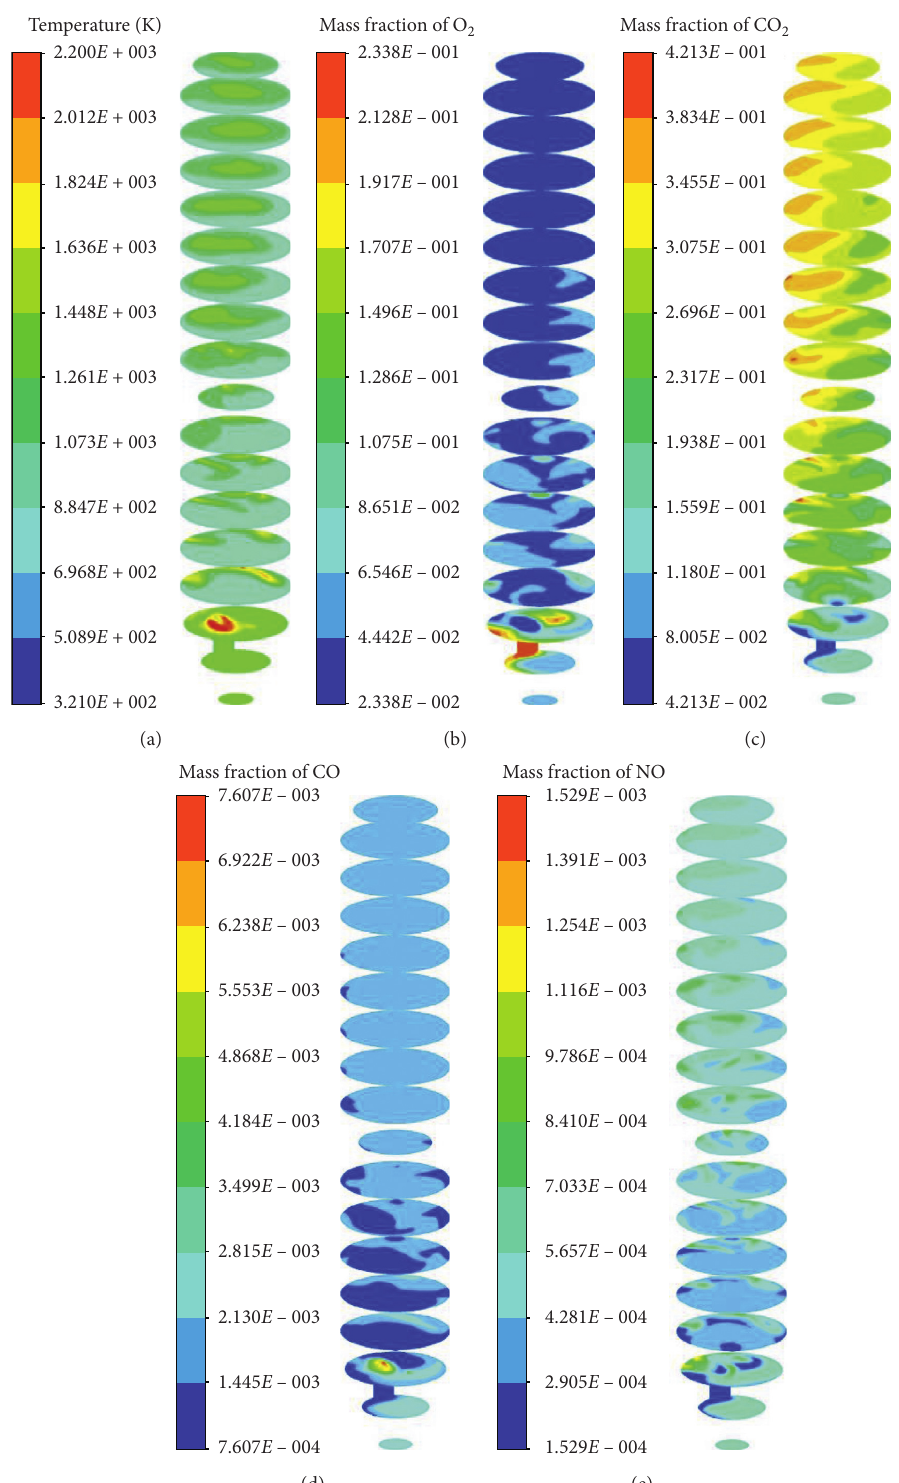
Figure 4: Numerical simulation of combustion in the decomposing furnace. (a) Temperature. (b) O